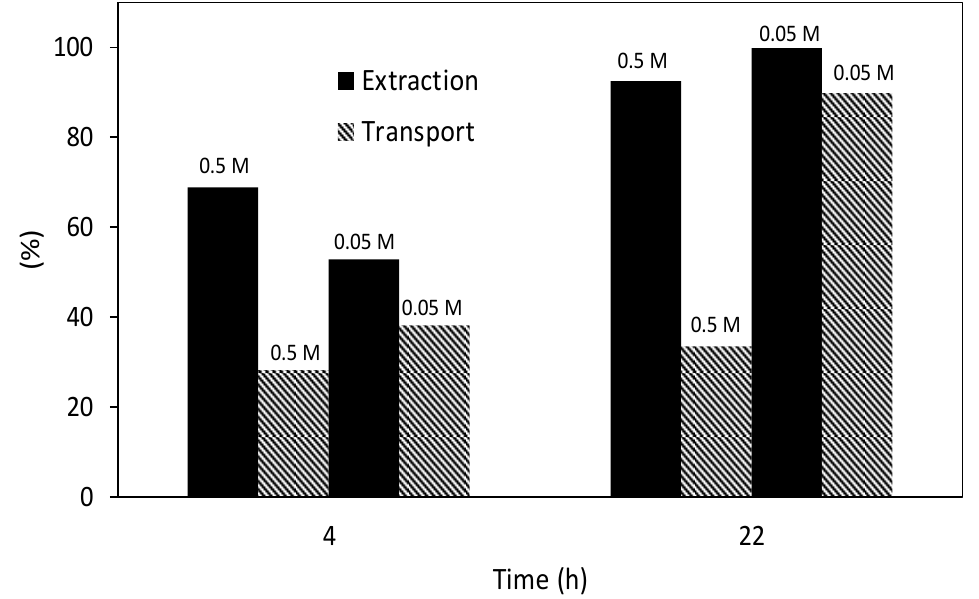
Figure 6. Influence of Aliquat 336 concentration on Cd(II) extraction and transport efficiency using a HFSLM. Feed solution: 2 mg L − 1 Cd in 1 M NaCl.